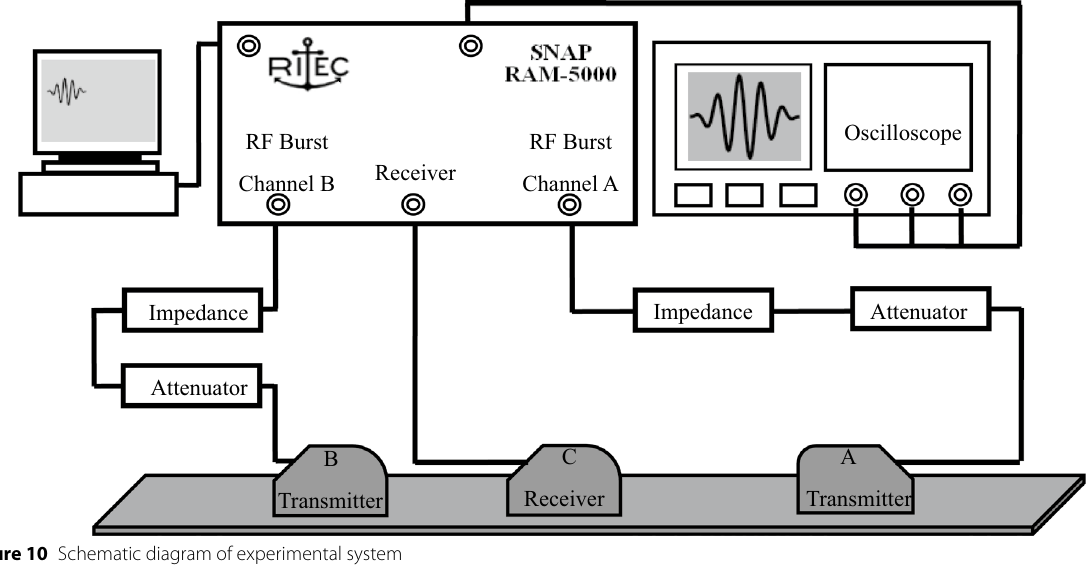
Figure 10 Schematic diagram of experimental system